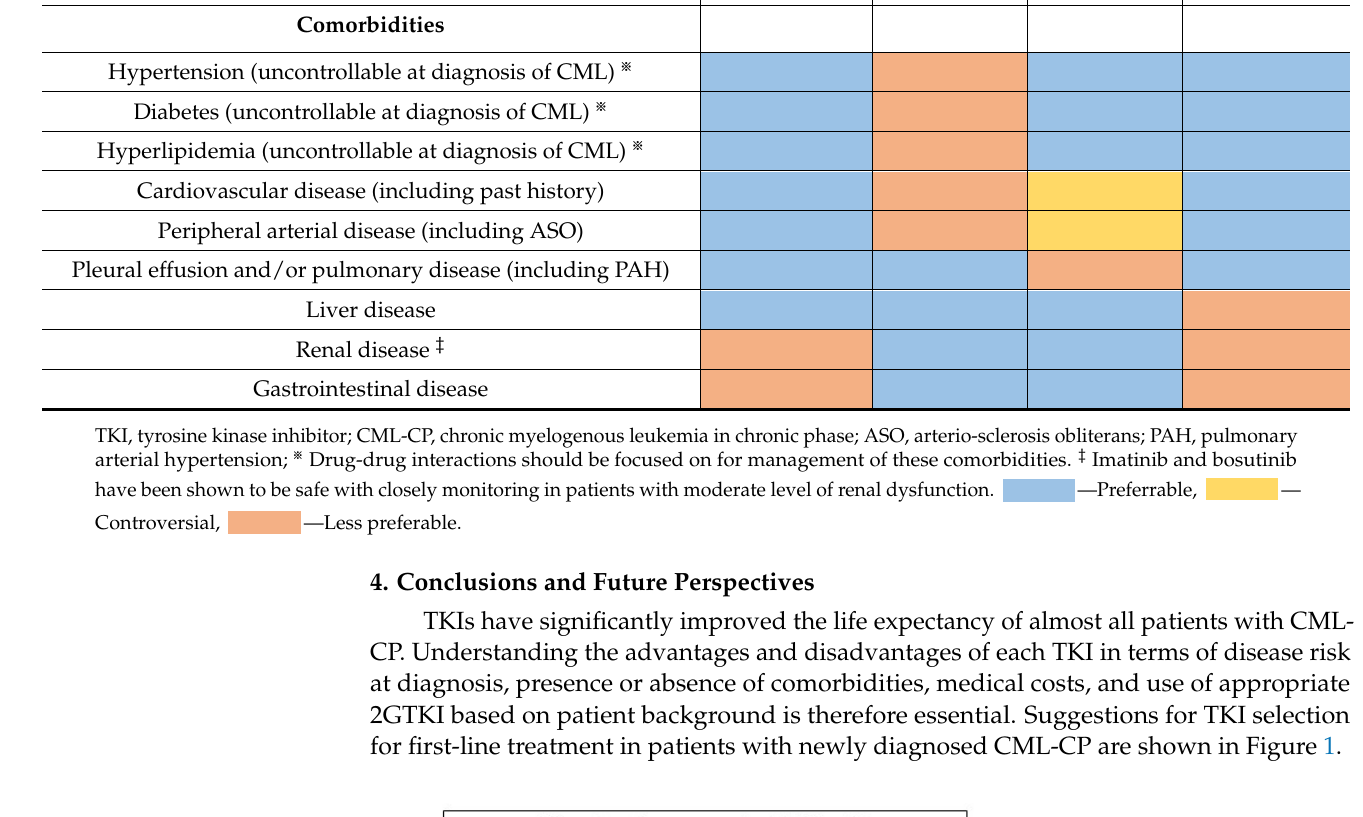
Table 2. Selection of TKIs for first-line treatment in patients with newly diagnosed CML-CP based on several comorbidities.